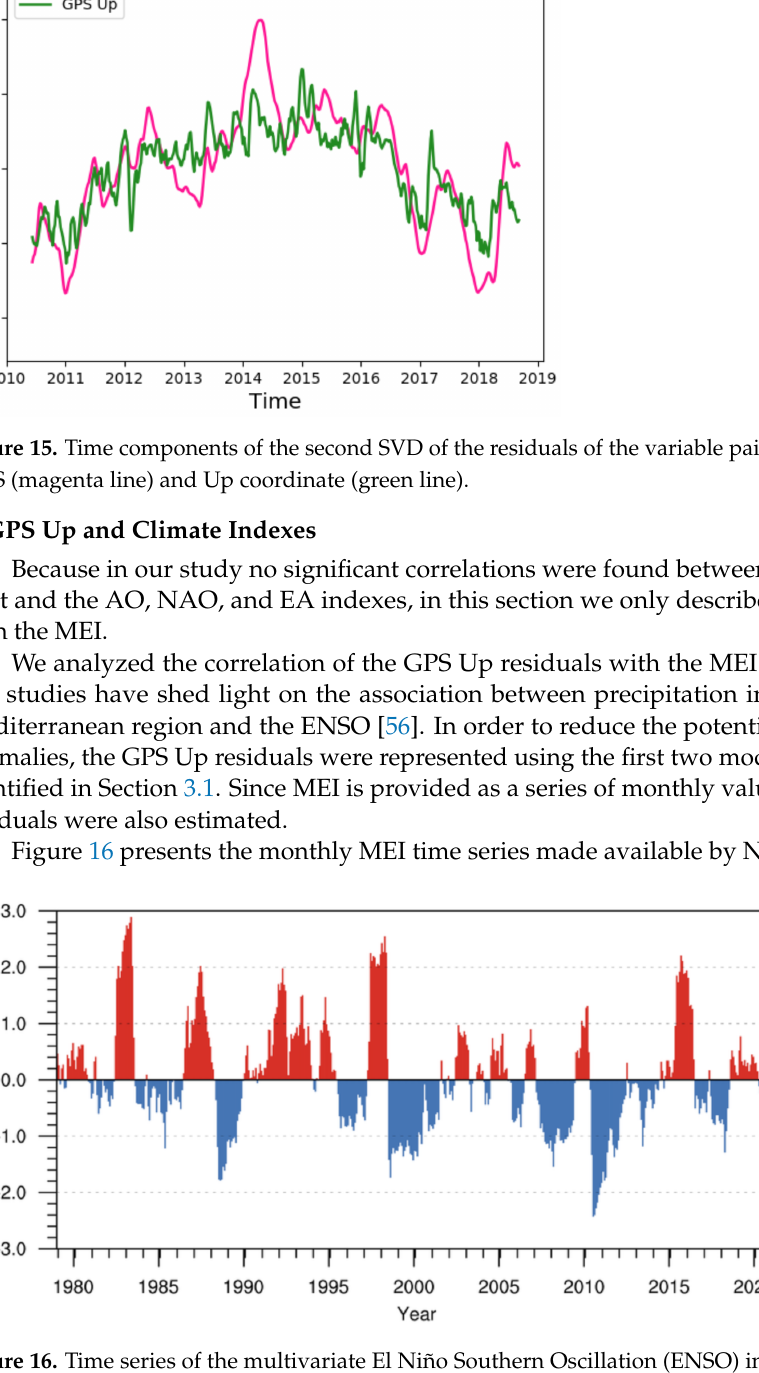
Figure 16. Time series of the multivariate El Niño Southern Oscillation (ENSO) index (MEI)v2. The red color represents the warm phase (El Niño) while the blue color indicates the cold phase (La Niña). Image downloaded from https://psl.noaa.gov/enso/mei/, accessed on 20 January